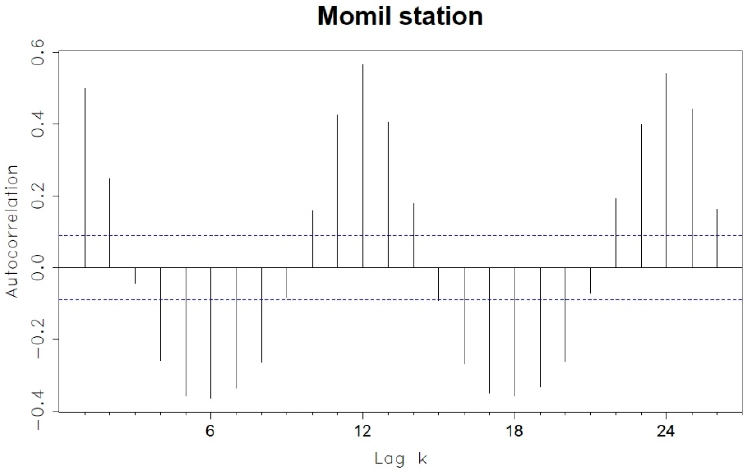
Figure 6. Autocorrelation function (ACF) of the calibration vector of the transformed precipitation time series using Box–Cox.